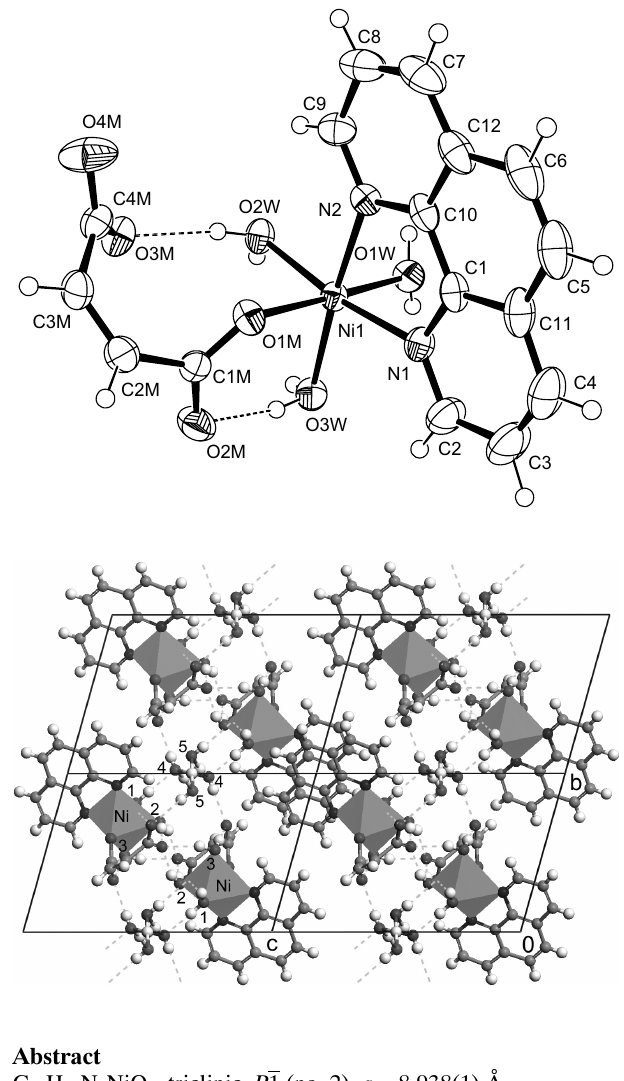
Source of material according to the procedure described in the literature for